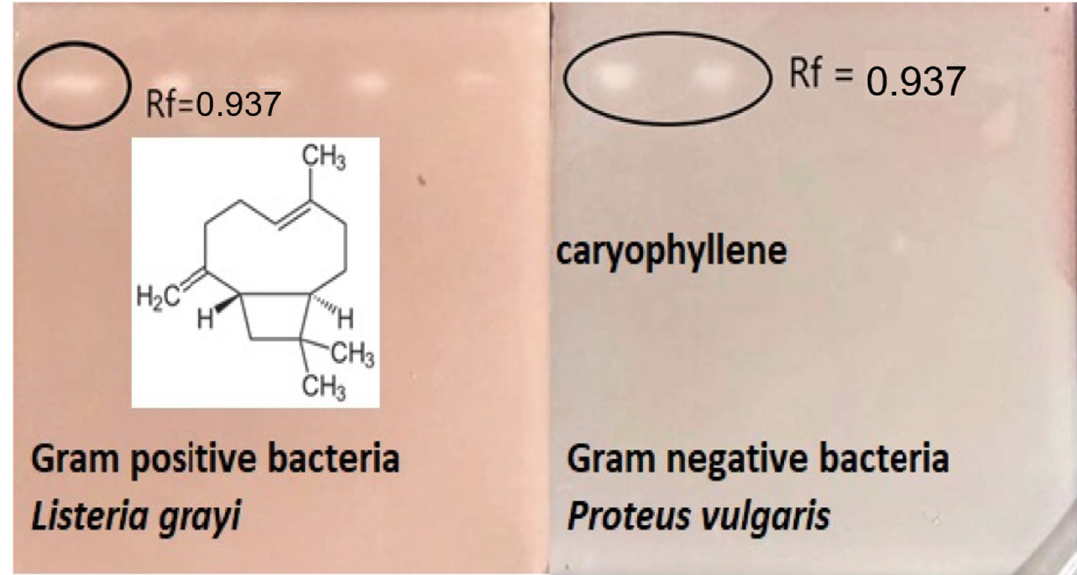
Figure 3. Bioautographic antibacterial assay of Clinopodium brownei essential oil, bioactive molecule Rf 0.937